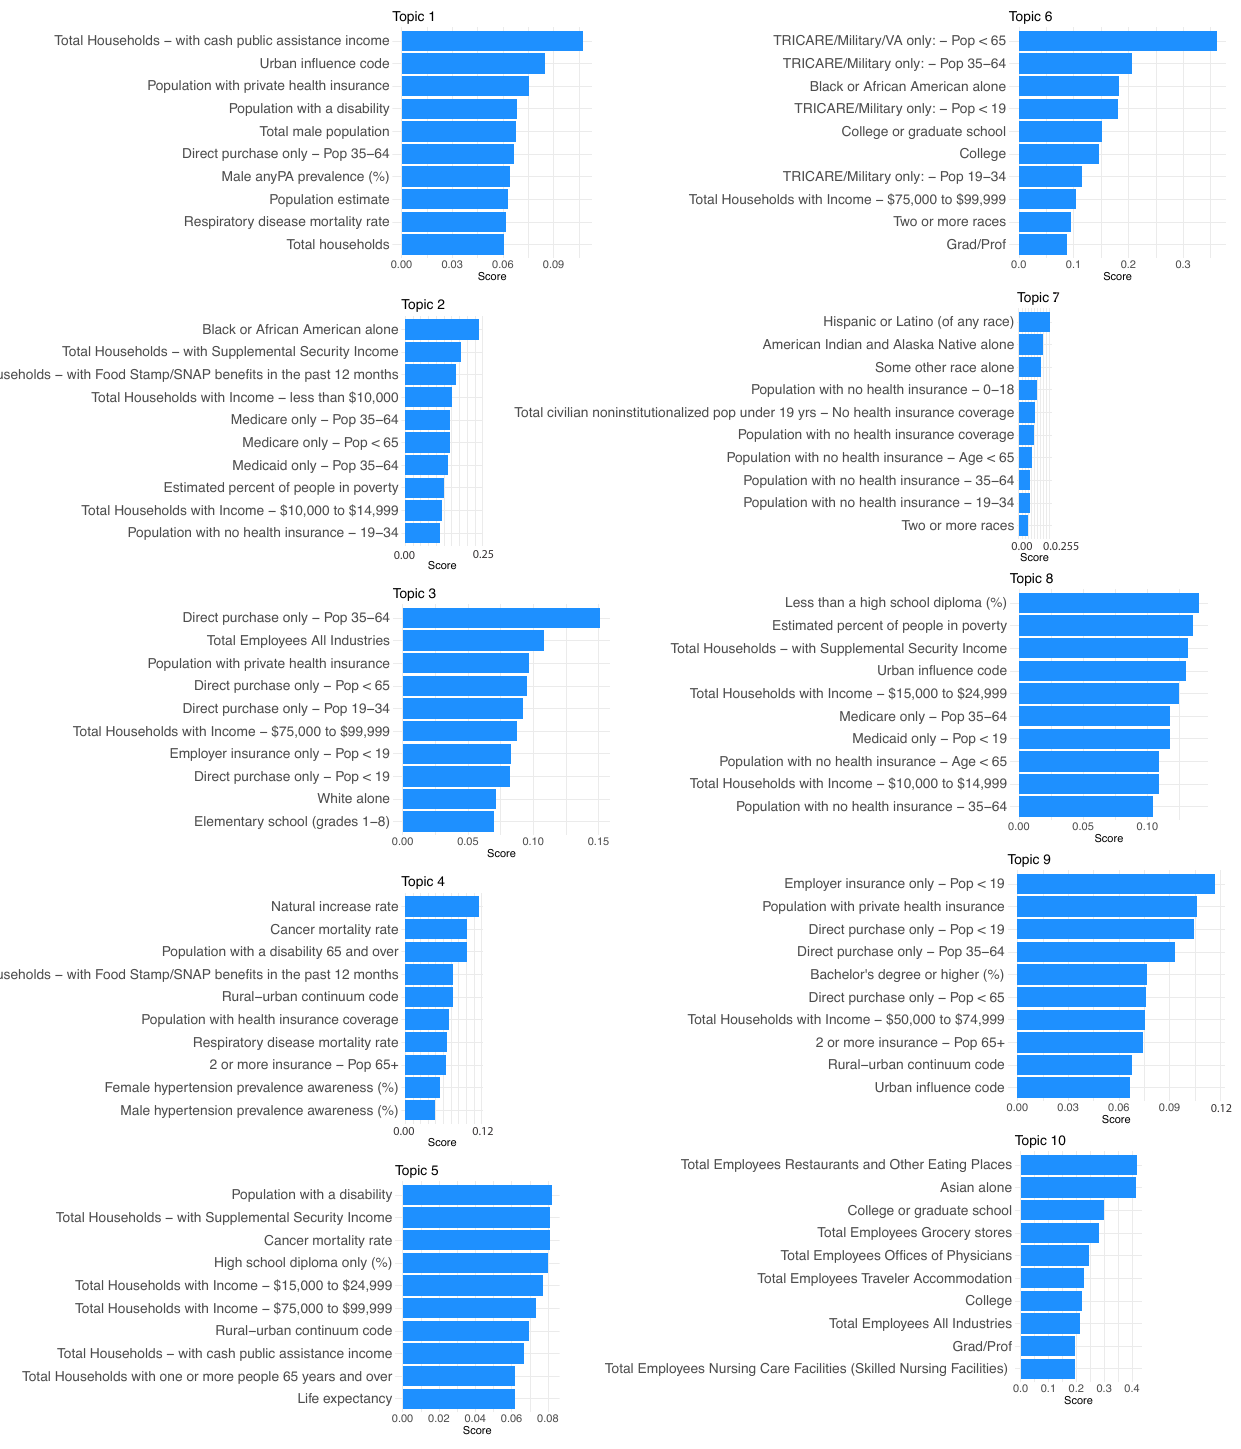
Figure A8. Top 10 feature scores for spatial features associated with each